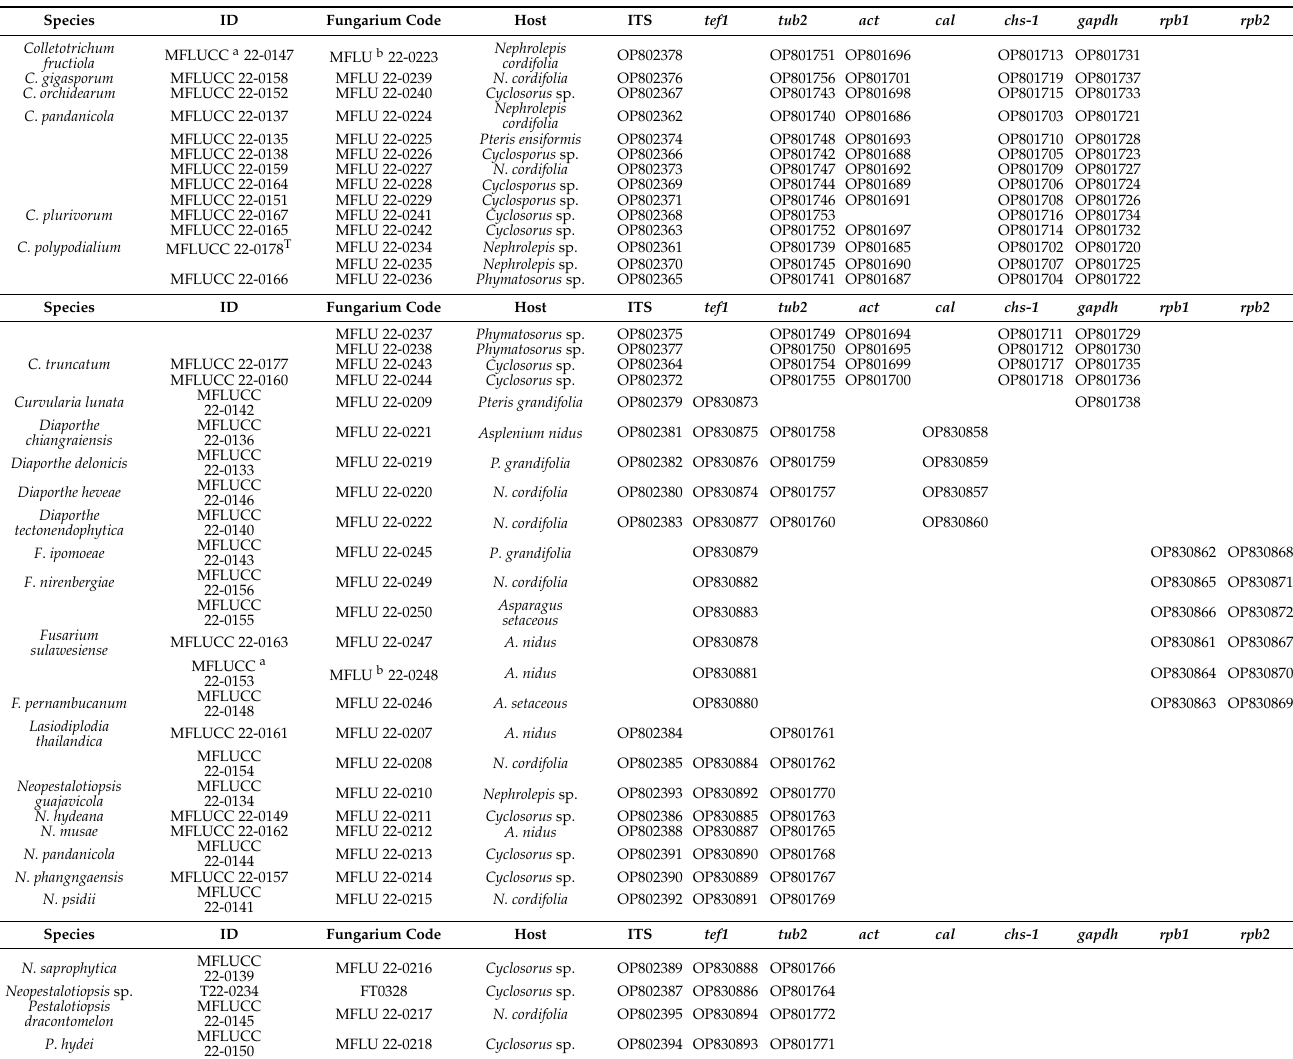
Table 3. GenBank accession numbers of taxa isolated in the present